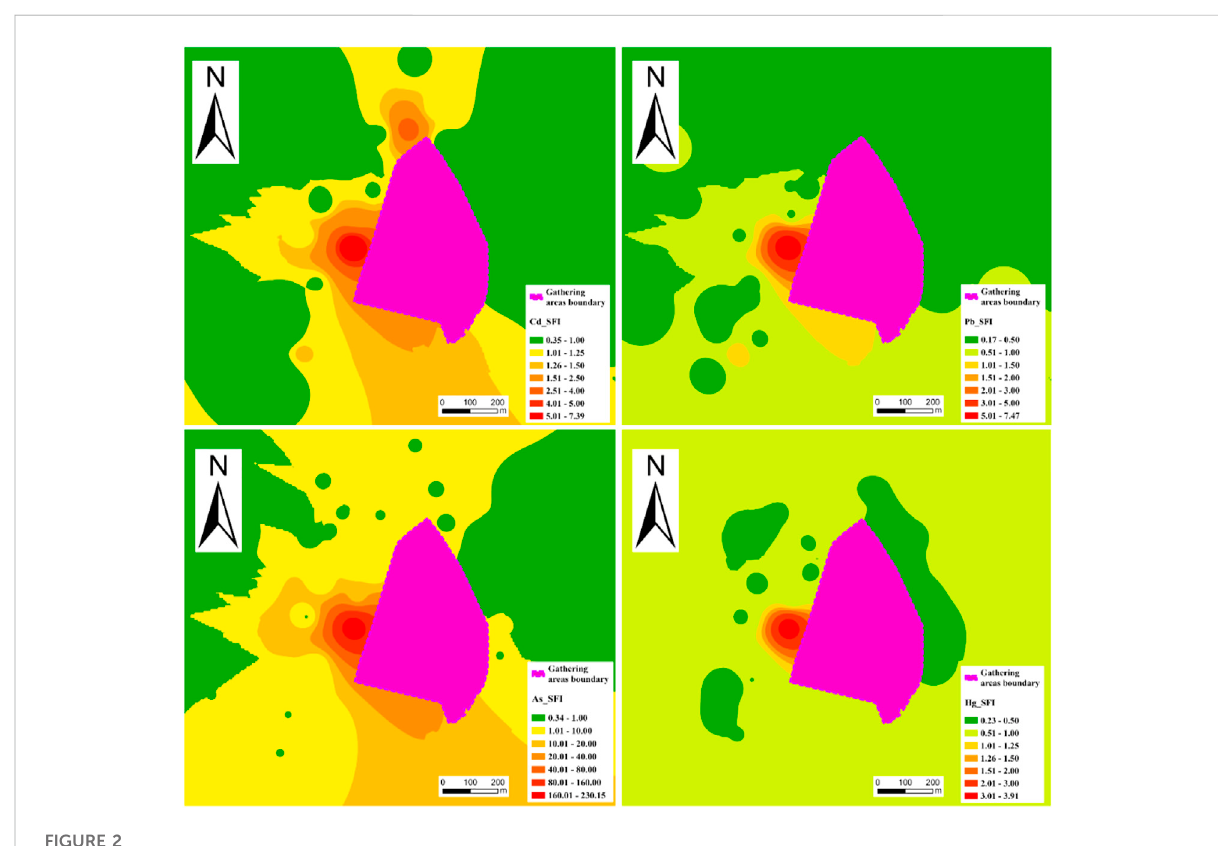
FIGURE 2 Spatial distribution of single-factor pollution